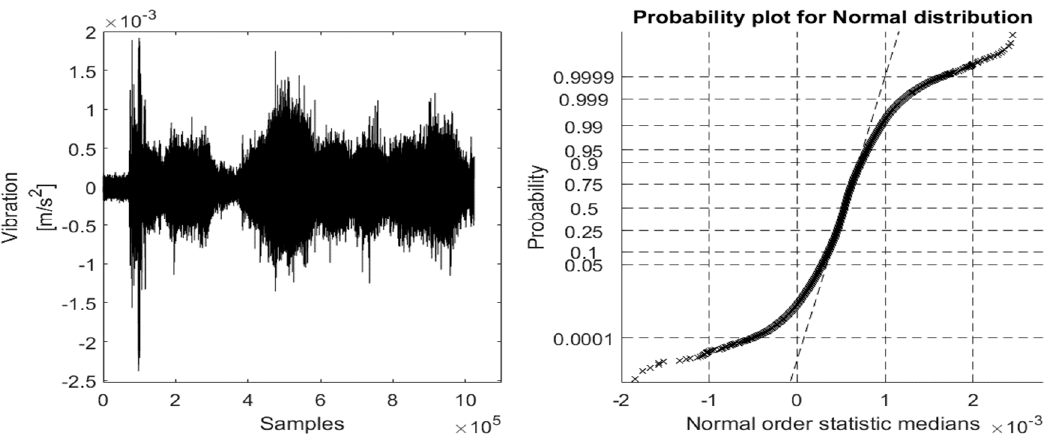
Figure 16. Raw vibration data signal from accelerometer #2 and its ProbPlot in bearing fault free (BFF) case under variable speed environment.